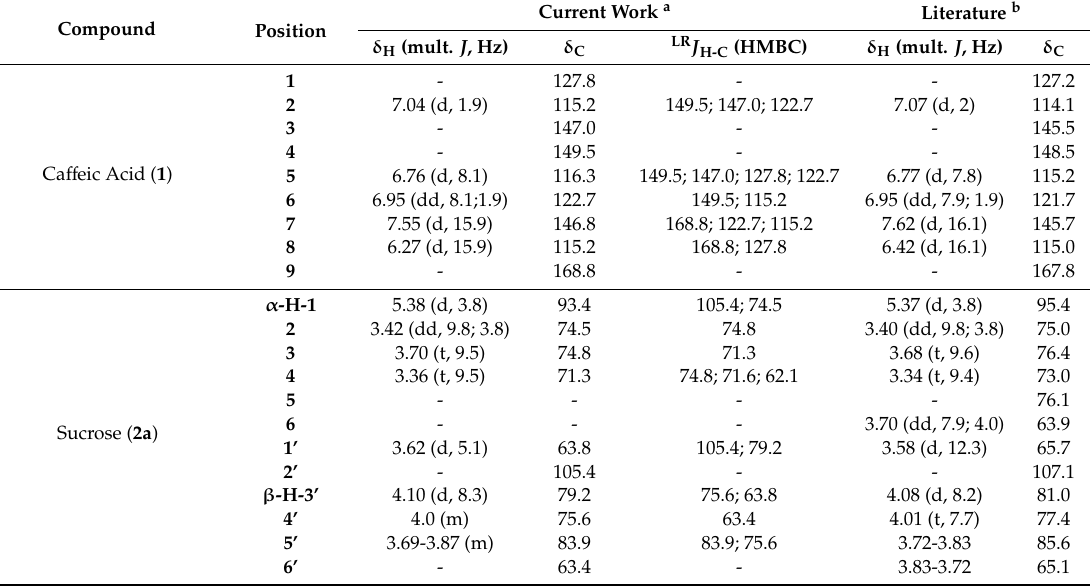
Table 1. High-Resolution Magic Angle Spinning Nuclear Magnetic Resonance (HR-MAS NMR) chemical shift assignments of all metabolites detected in leaves, roots, and stems of Berberis laurina Billb.